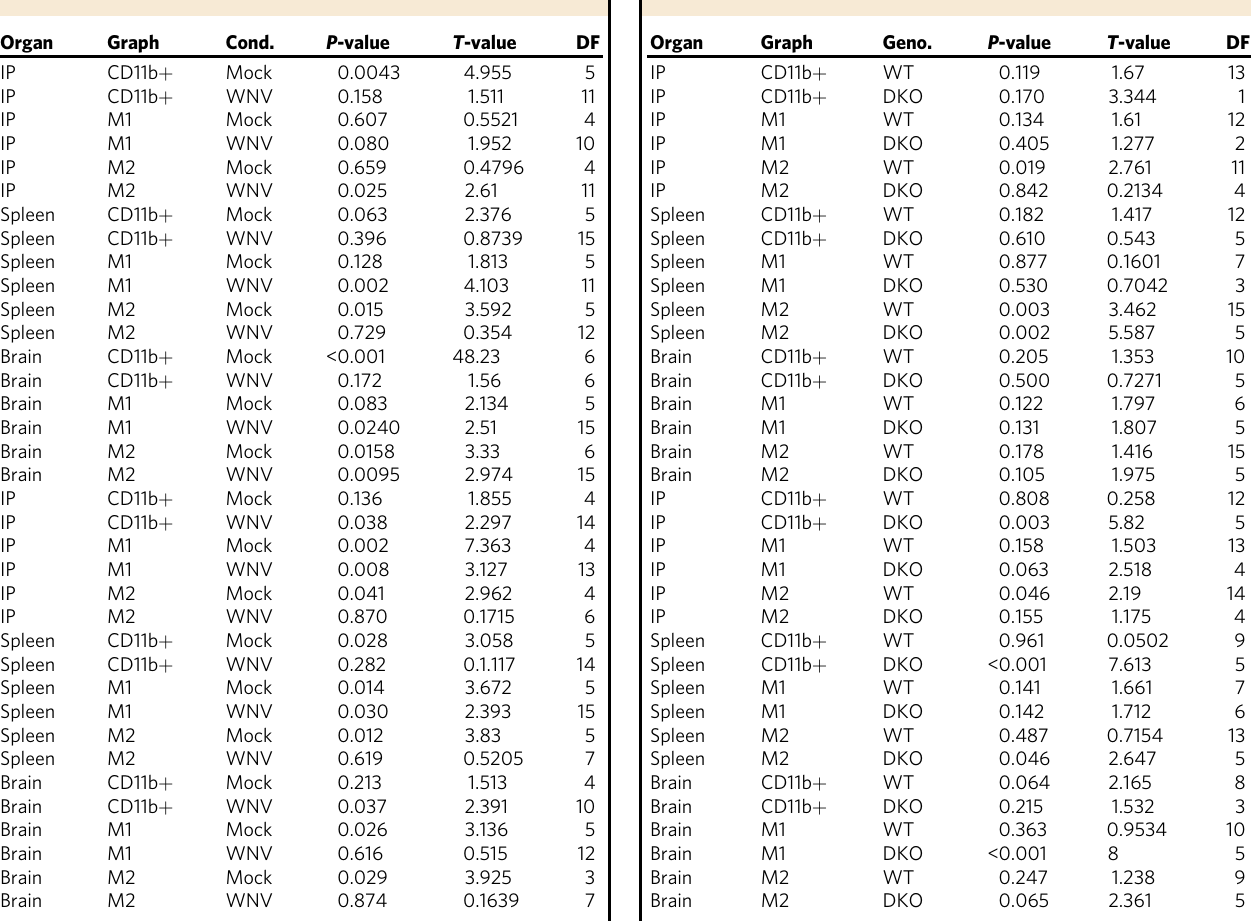
Table 3 Statistical details for Fig. 6c: Mock vs. WNV